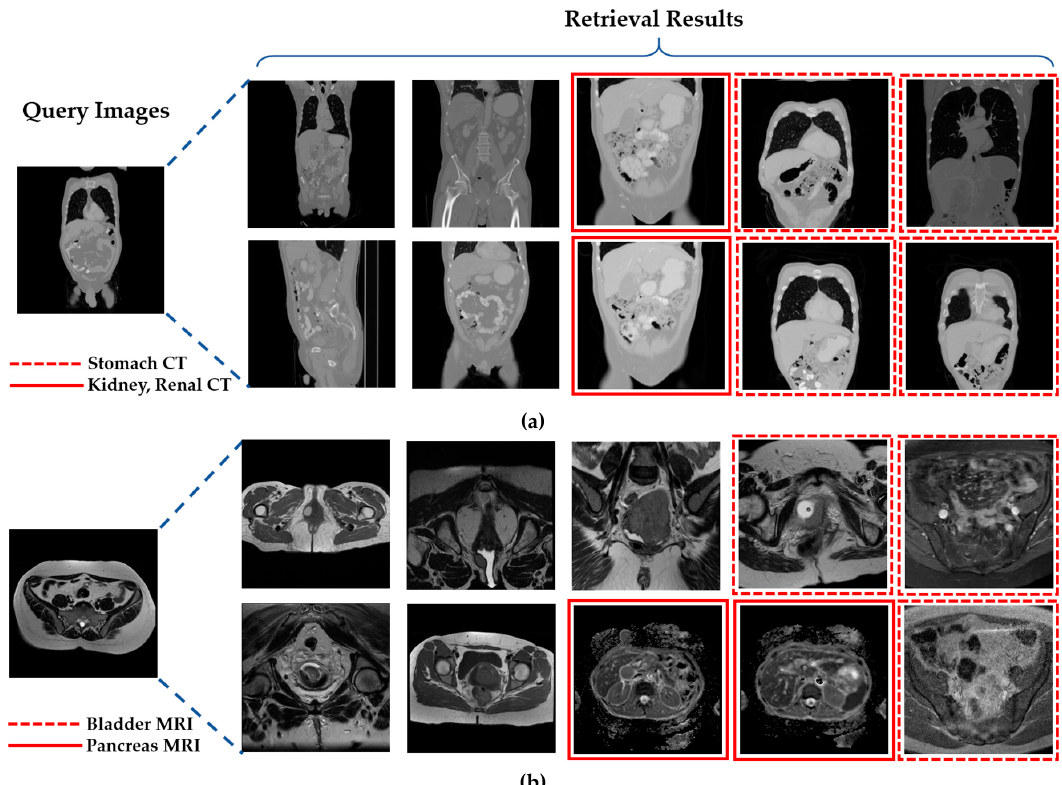
Figure 17. Class-prediction-based false retrieval performance of our proposed system. ( a ) Bladder CT scan as a query image; ( b ) cervix MRI scan as the query image.